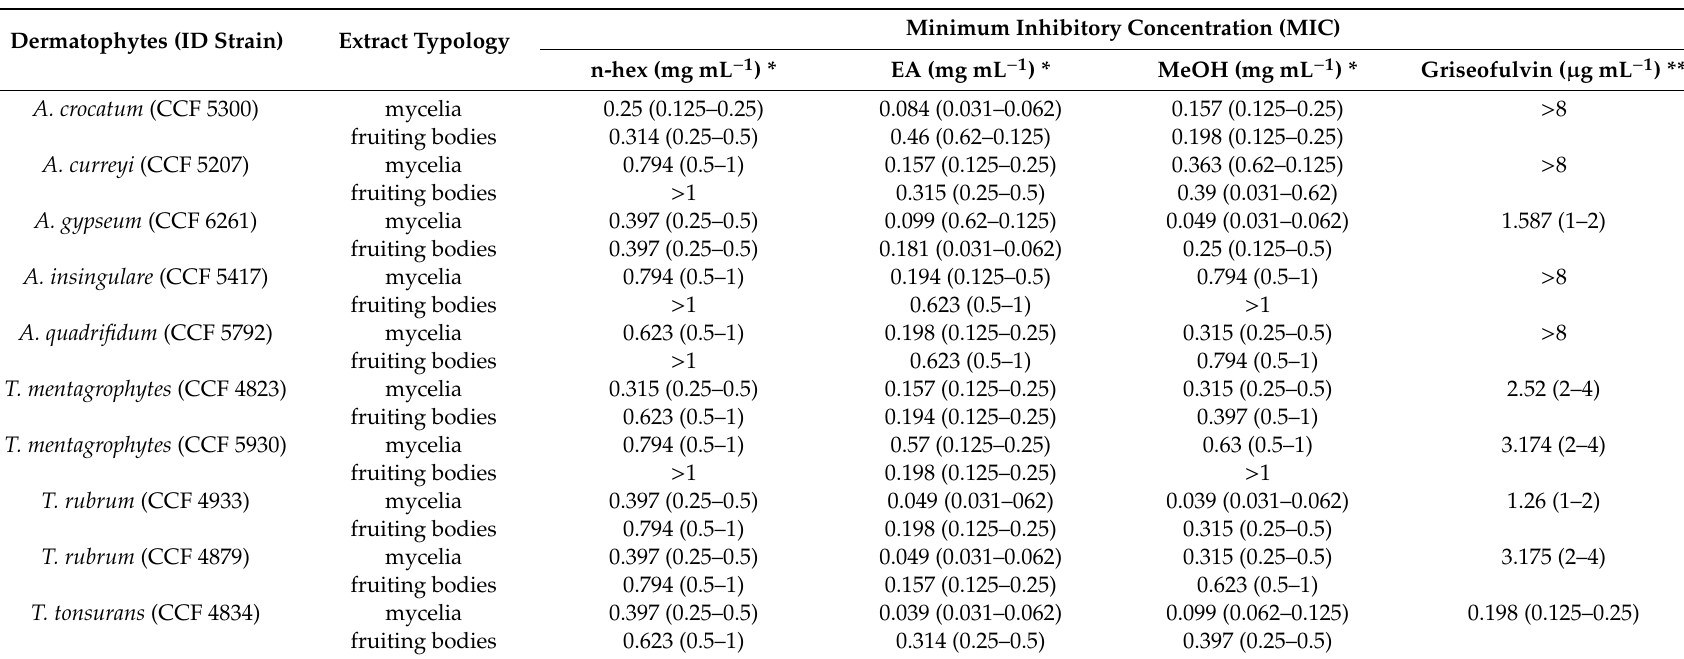
Table 6. Minimal inhibitory concentrations (MICs) of T. goniospermum n-hexane, ethyl acetate and methanol extracts, and griseofulvin towards selected dermatophytes. Dermatophytes (ID